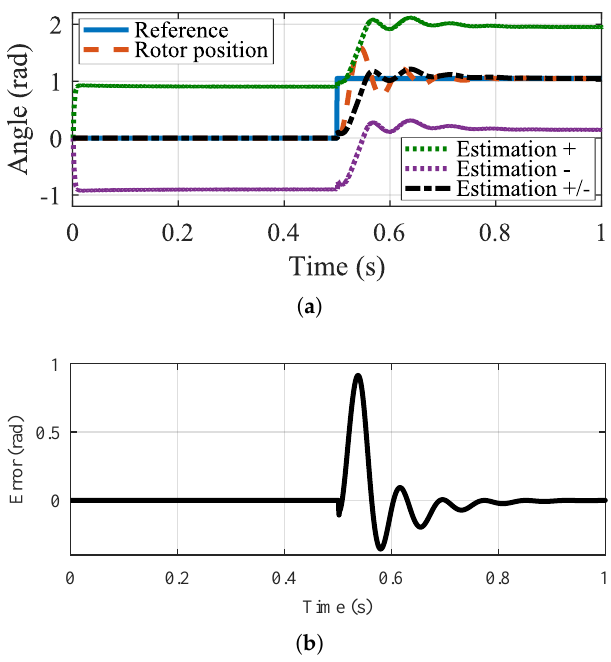
Figure 5. Simulation results extracting both components. ( a ) Reference angle (blue solid), rotor position (dashed orange), estimated angle (dotted green) from positive sequence, estimated angle (dotted purple) from negative sequence, estimated angle (dash-dot black) using both signals. ( b ) Estimation